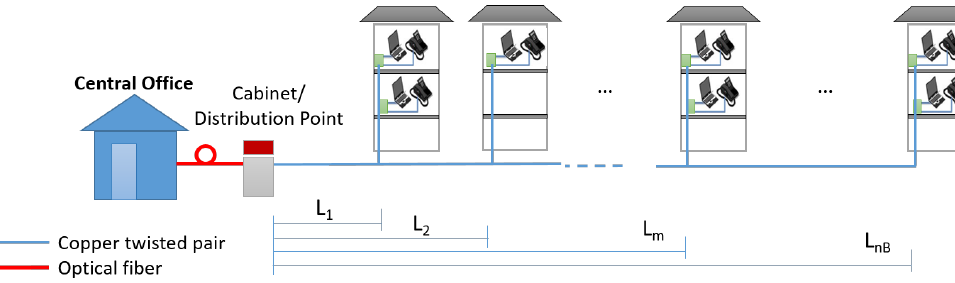
Figure 1. Considered FttC/FttDp generic interference scenario, where { L i } are the distances of the buildings from the